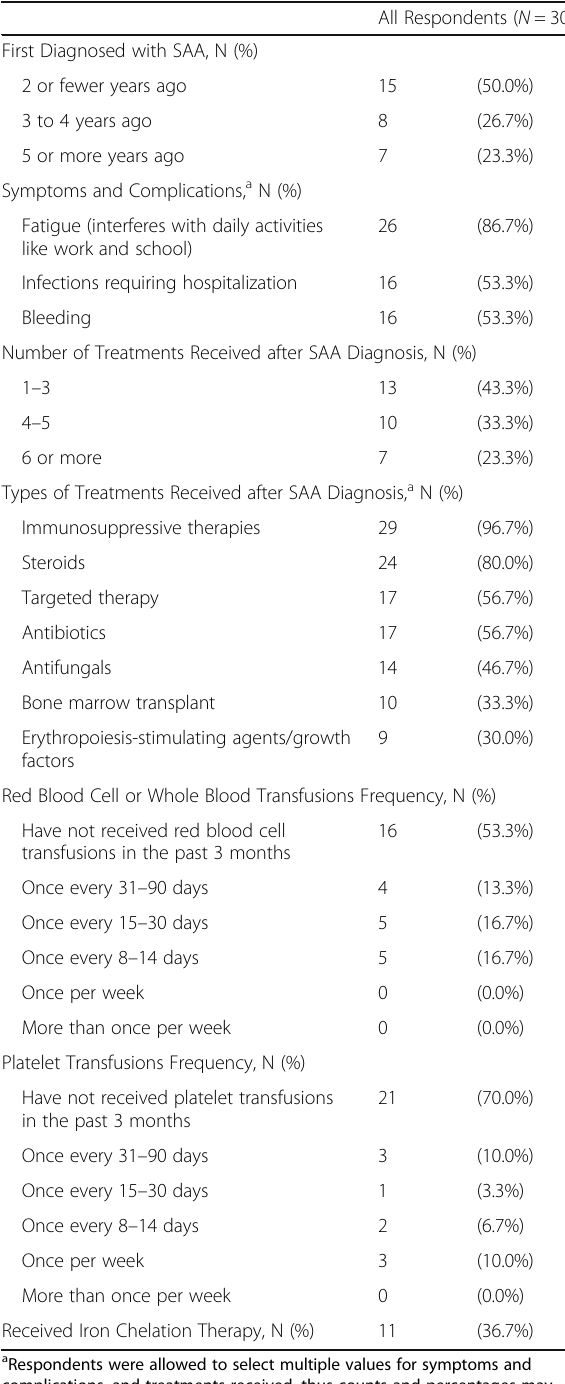
Table 2 Diagnosis and treatment Table 1 Respondent